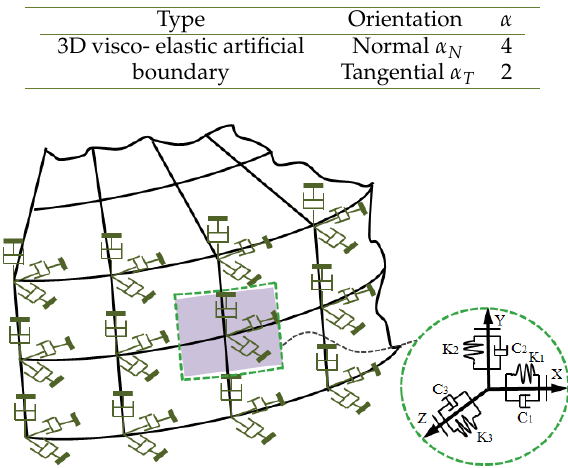
Fig. 2. Viscoelastic artificial boundary specified in the 3D finite element